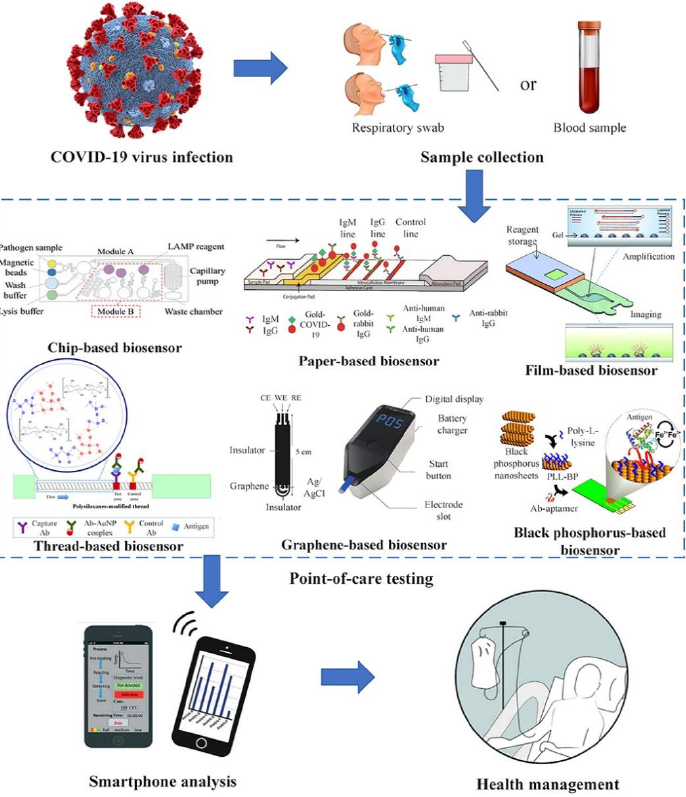
Figure 1. Point-of-care biosensors for coronavirus disease 2019 (COVID-19) (Adapted from Reference [54] with the permission under the terms of Creative Commons Attribution License).